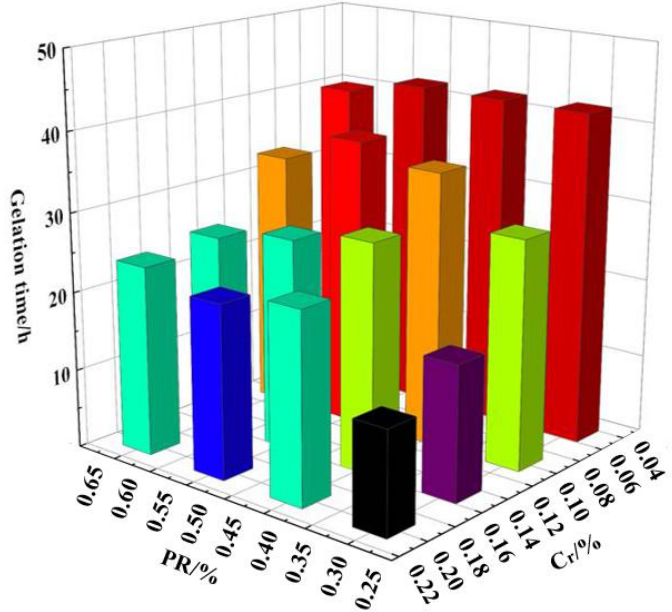
Figure 7. Histogram of gelation time (h) of 0.45% HPAM + PR and Cr 3+ cross-linker. (The color represents gelation time of